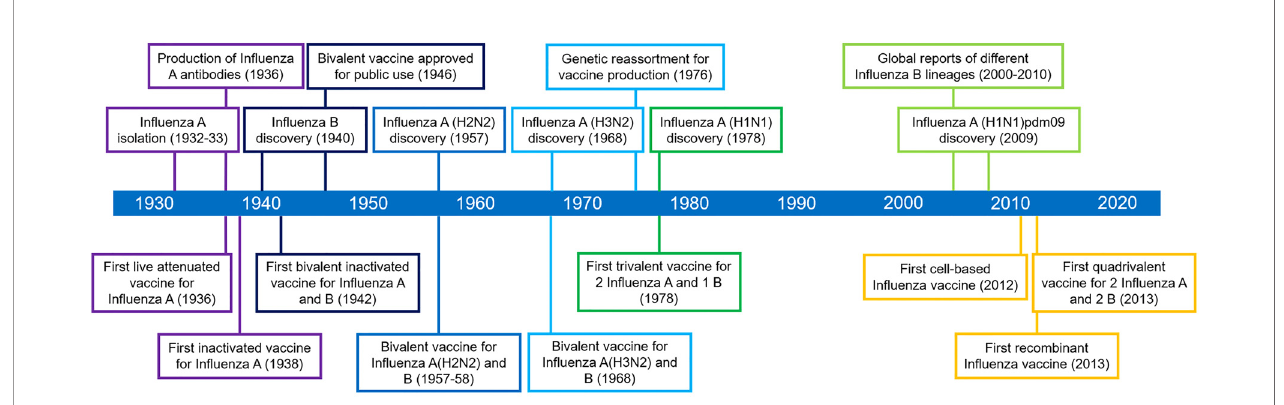
FIGURE 3 | Historical timeline of in fl uenza vaccine